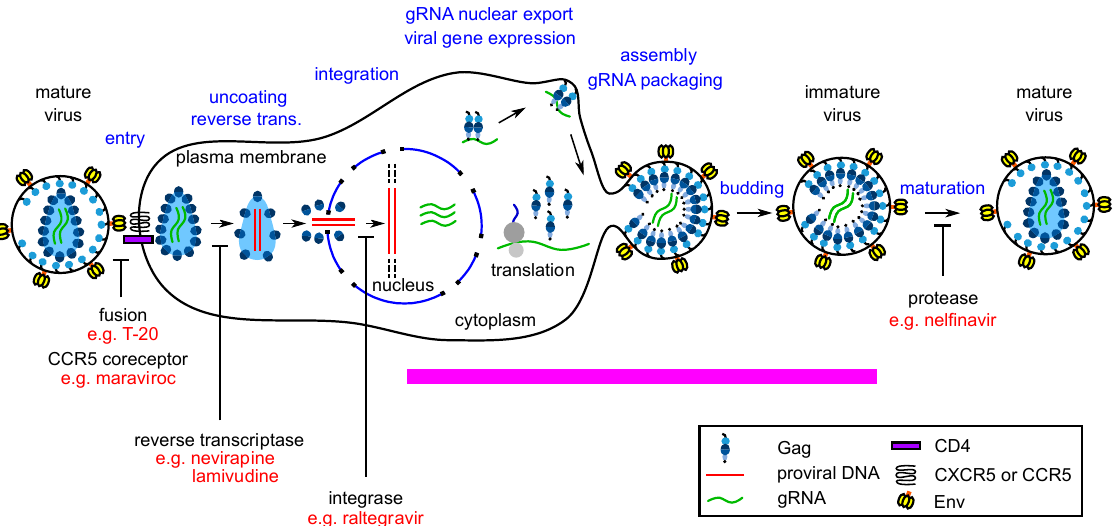
Figure 1. Diagram of the HIV-1 life cycle showing points of inhibition by FDA-approved drugs. Stages of the life cycle are labeled in blue font above the diagram. Events that are inhibited are shown with vertical blockade arrows below and labeled in black font, with an example of one drug in each category labeled in red font. The pink bar indicates late events in the viral life cycle that are not yet inhibited by an FDA approved drug, leaving a large gap in the ARV armamentarium.